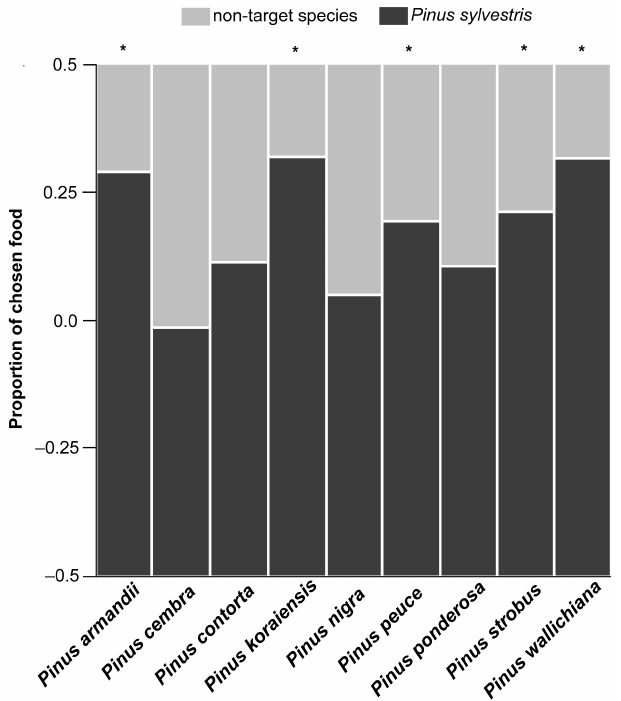
Figure 2. A mosaic plot showing proportion of chosen food by the pine-tree lappet larvae ( Dendrolimus pini L.) in the dual-choice experiment with Pinus sylvestris L. and non-target species. Symbol * at the top of the bars indicate significant differences in the larval selection of the target and non-target host plants.